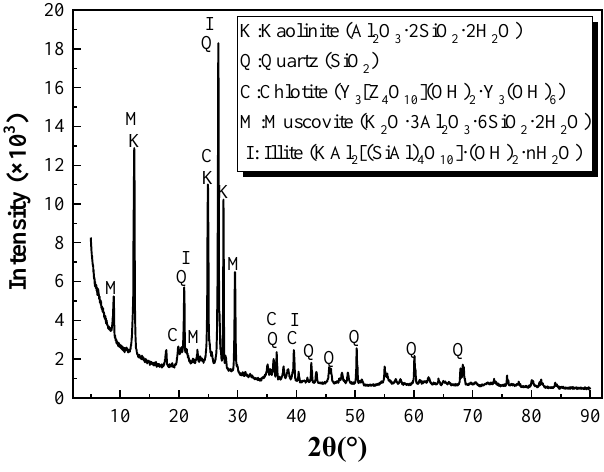
Figure 1. XRD spectra of raw coal gangue. Table 1. Primary chemical compositions of raw coal gangue.